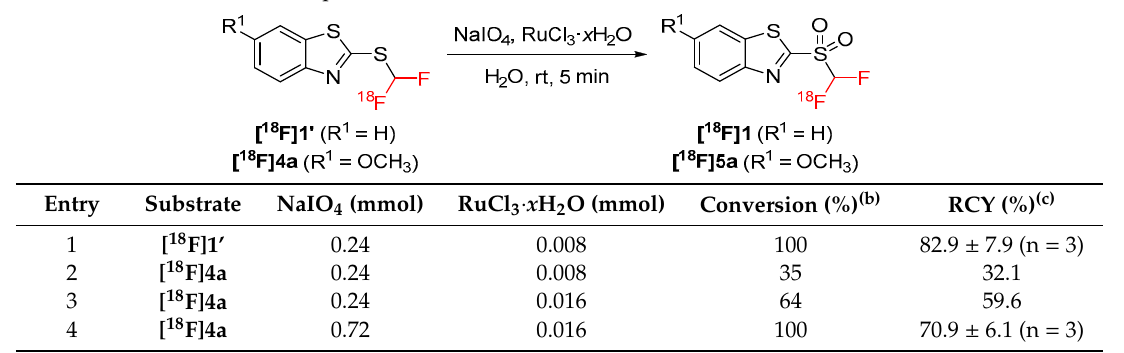
Table 1. Optimization of the oxidation conditions of the [ 18 F]4a (a) .